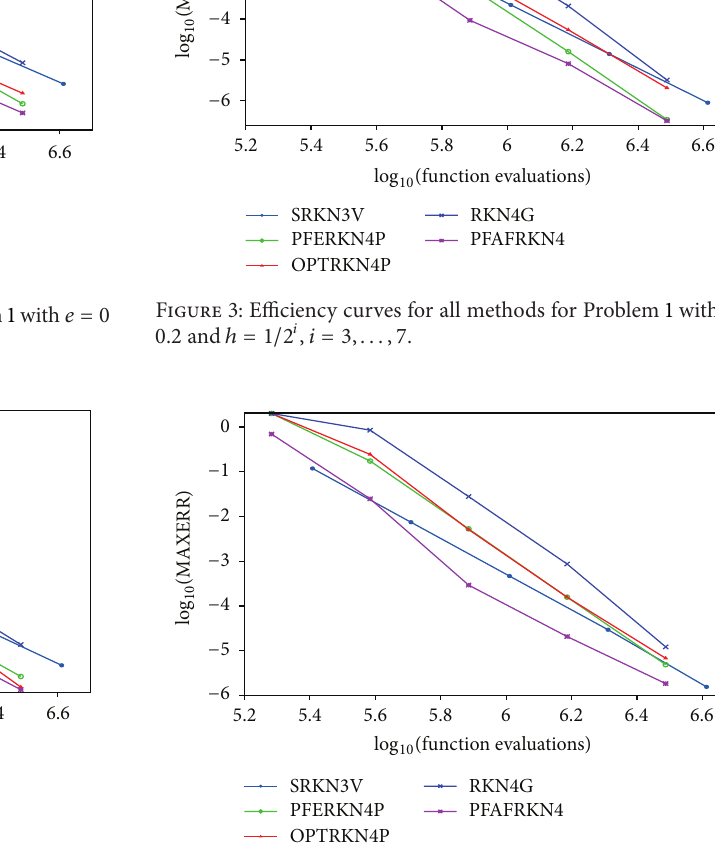
Figure 2: Efficiency curves for all methods for Problem 1 with 𝑒 = 0.1 and ℎ = 1/2 𝑖 , 𝑖 = 3,...,7 .